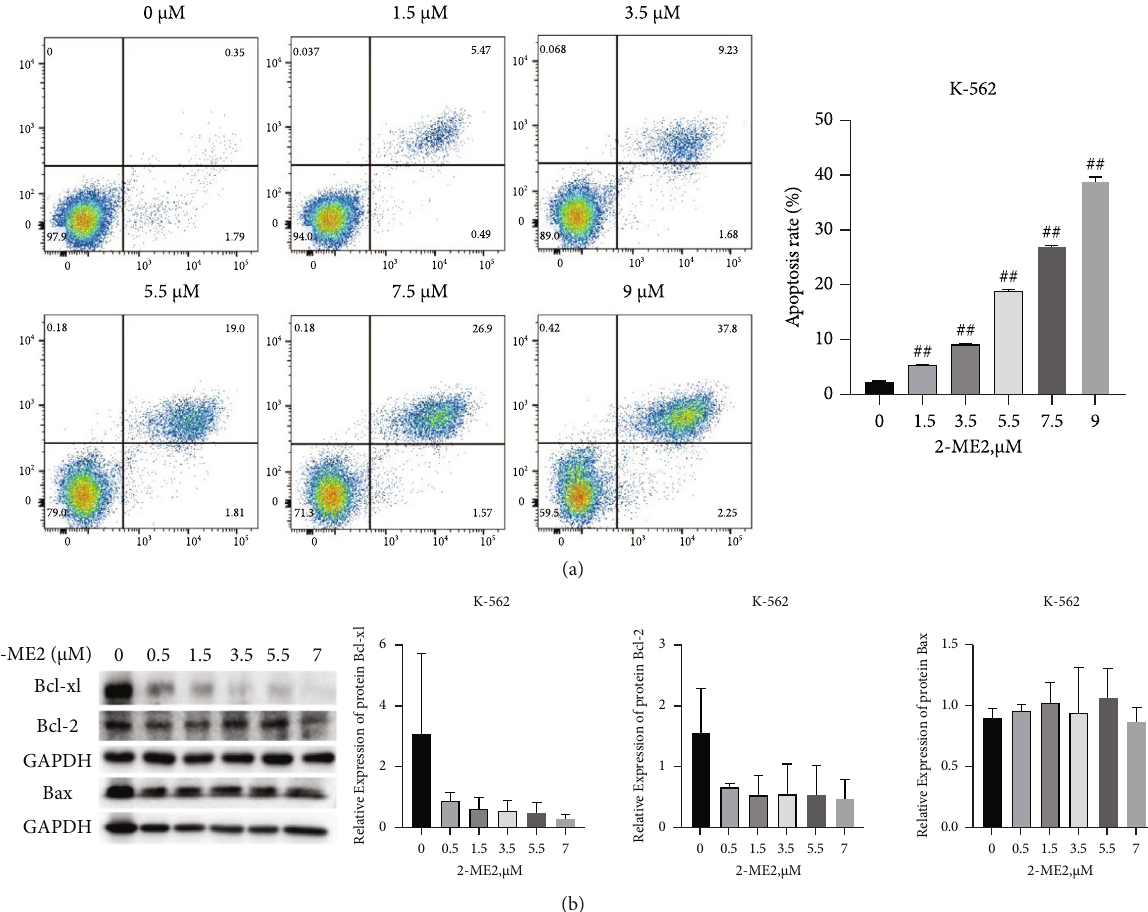
Figure 4: Apoptosis of K-562 cells after treatment with 2-ME2 for 24h. (a) Flow cytometry detection of cell apoptosis. (b) Western blot detection of Bcl-xl, Bcl-2, and Bax protein expressions. Compared with control group, ## P < 0 : 01 .